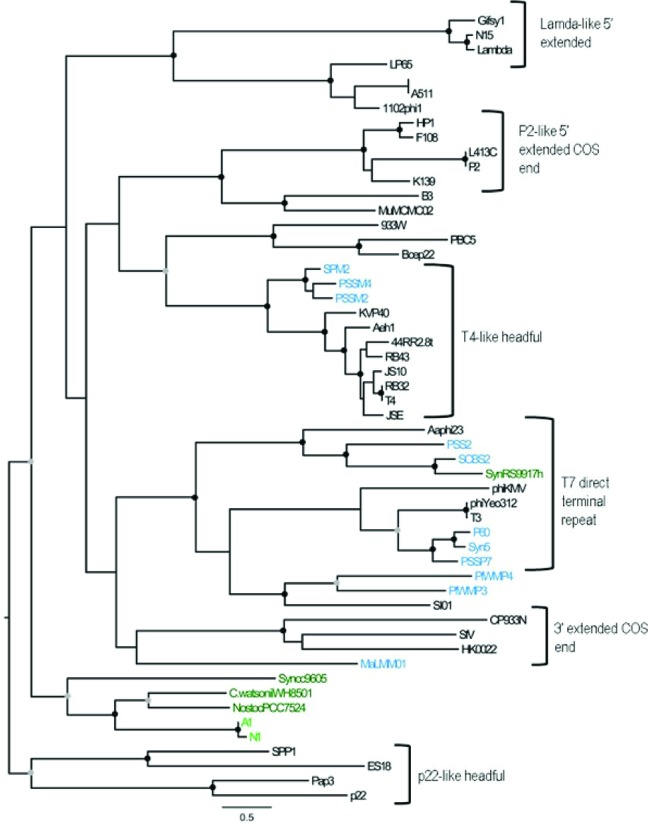
Phylogenetic relationship of terminase large subunit protein sequences from phages. A ML tree is shown with bootstrap values of 90 to 100% (black circles) and 75 to 89 % (gray circles) shown at the nodes. The sequence names are colored as follows: light green, Nostoc cyanophages; dark green, cyanobacteria; light blue, other cyanophages; black, other viruses.